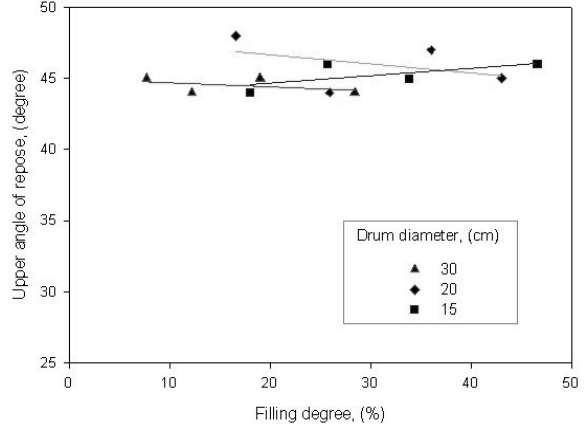
Fig. 5: Effect of filling degree on upper angle of repose for cylinders with diameters equal to 15, 20, and 30 cm.